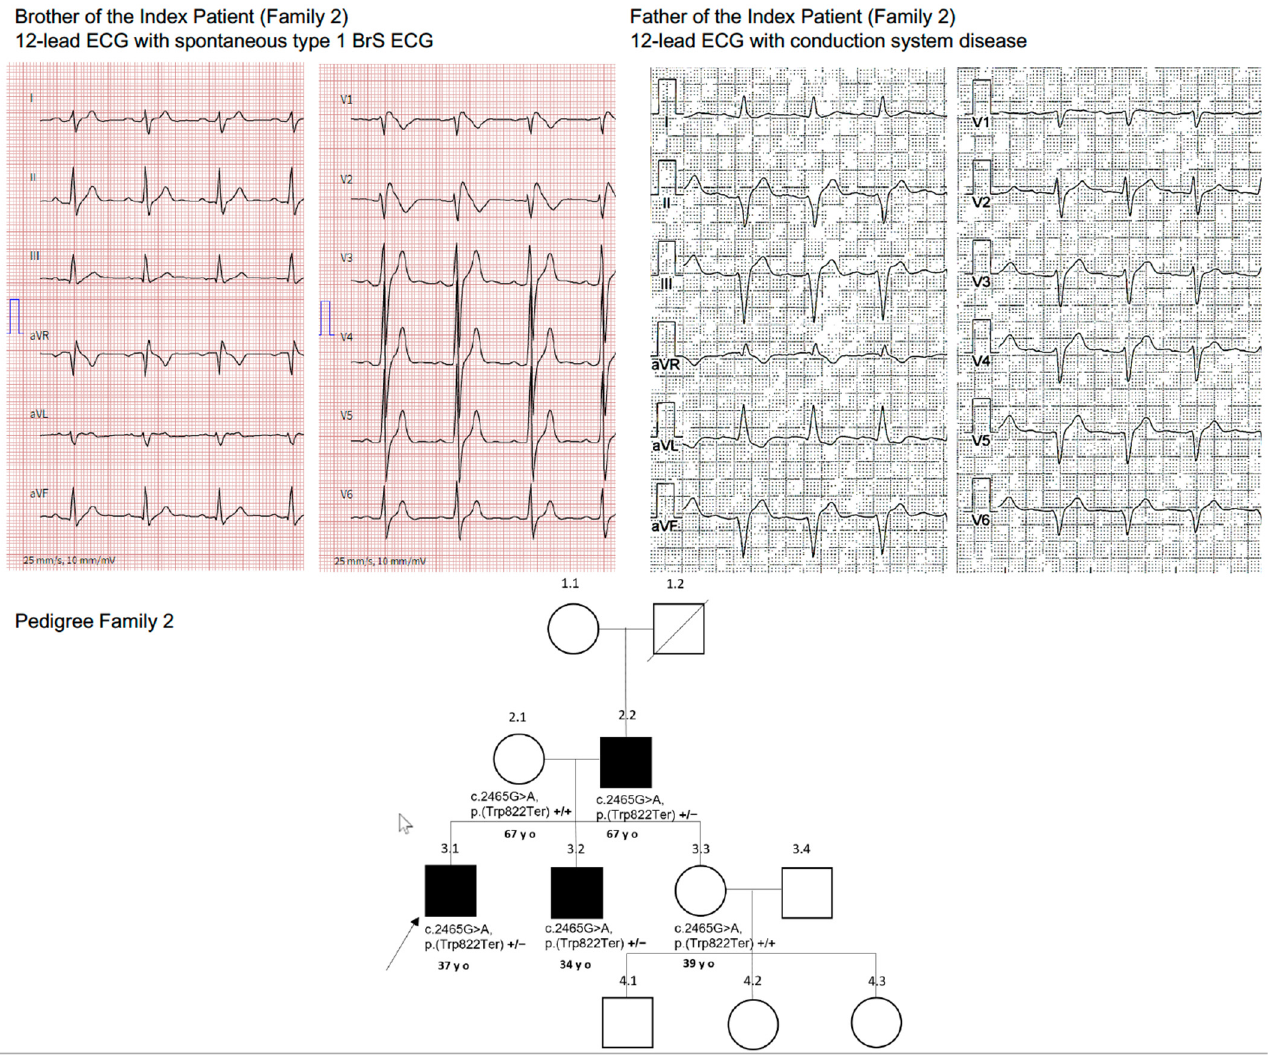
Figure 2. Family